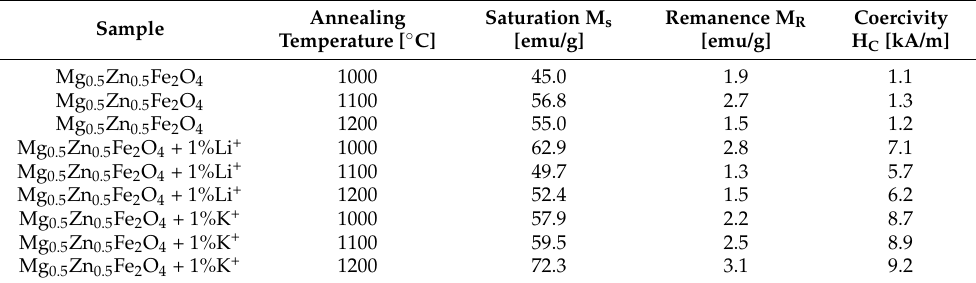
Table 2. Summary of the magnetic properties of Mg-Zn ferrites.